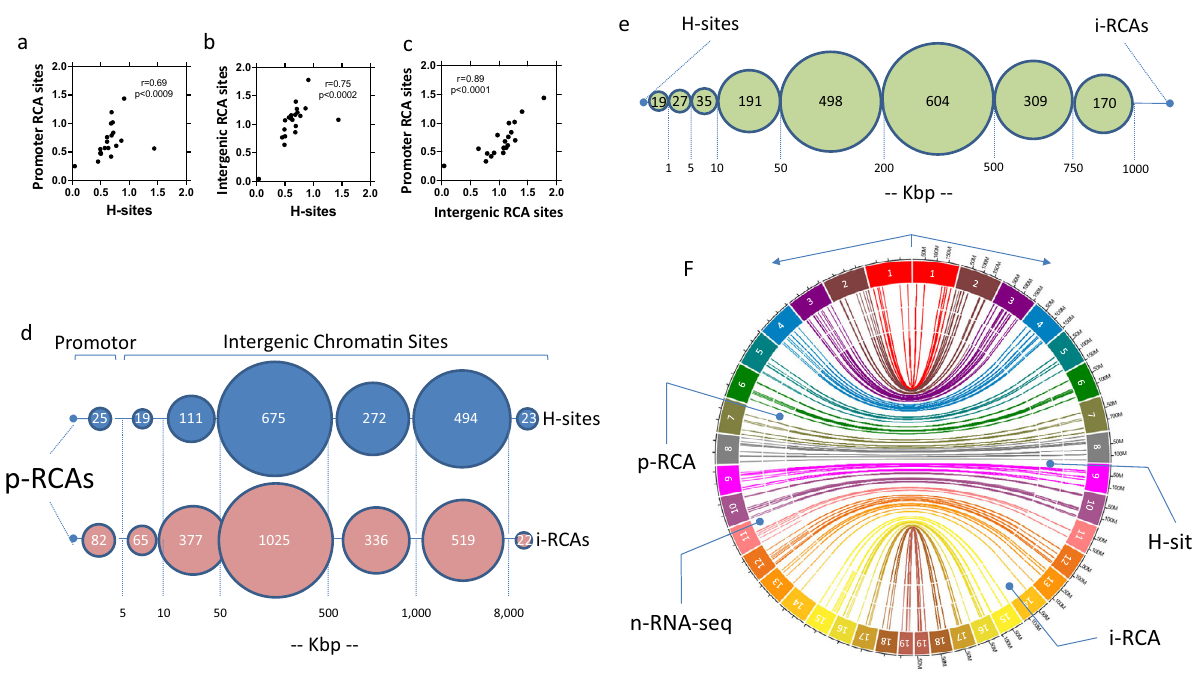
Fig. 4 Interrelationship between H-sites and RCA areas in the ALB-D2KO mouse liver. a correlation between the density (number of H-sites/size of the chromosome) of H-sites and promoter RCAs sites in each chromosome; the nonparametric Spearman r and the statistical signi fi cance are indicated; no adjustments were made for multiple comparisons [ p < 0.0009 (two-tailed)]; b same as a , except that i-RCA sites were used [ p < 0.0002 (two-tailed)]; c same as a , except that promoter RCAs and i-RCA sites were used [ p < 0.0001 (two-tailed)]; d distance between H-sites and i-RCA areas vs. p-RCA areas; the number of H-sites and i-RCA areas at each distance bracket is indicated inside the circles; distances are indicated in Kbp; e same as c except that distances were calculated between intergenic RCA areas (i-RCA) vs. H-sites; there are 572 i-RCA located at a distance >1000 Kbp that are not indicated; f Circa representation of the 121 n-RNA-seq areas and p-RCA areas within 1000 bp of area-1 vs. the closest H-sites and i-RCA to area-2 areas across the Alb-D2KO liver genome; the outer most ring represents chromosome ideograms; on the right, the size of each chromosome is indicated in Mbp; the inner connecting lines indicate the Hi-C interacting points obtained from ref. 43